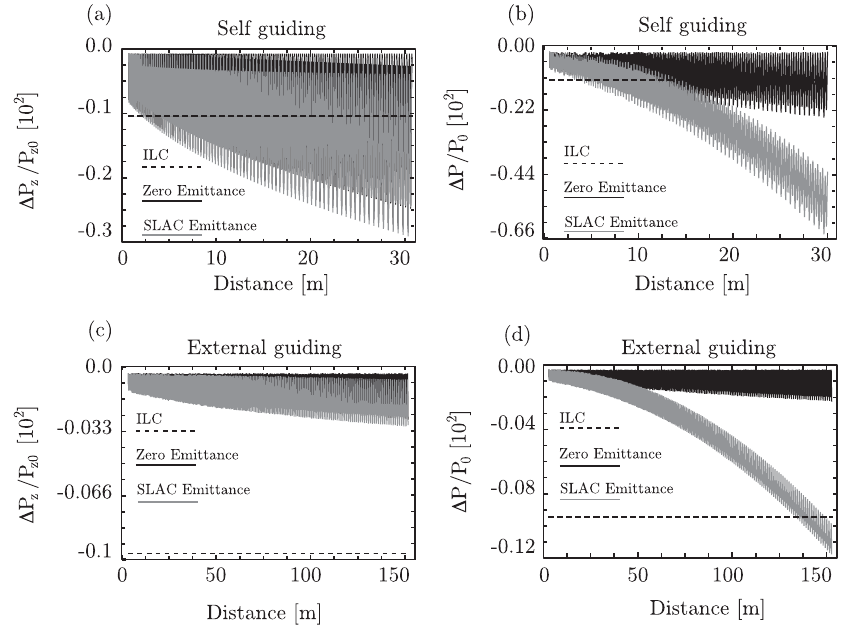
FIG. 5. Beam polarization evolution for a 0.5 TeV PBA. (a) Evolution of the longitudinal component of the polarization in a self- guided regime. (b) Evolution of the total polarization in a self-guided propagation regime. (c) Evolution of the longitudinal component of the polarization in an externally guided propagation regime. (d) Evolution of the total polarization in an externally guided propagation regime. The gray (black) line corresponds to a SLAC-like beam with (without) emittance, and the black dashed line corresponds to the typical depolarization that is expected for the ILC, which includes the depolarization of the beam at the interaction point between the colliding beams.